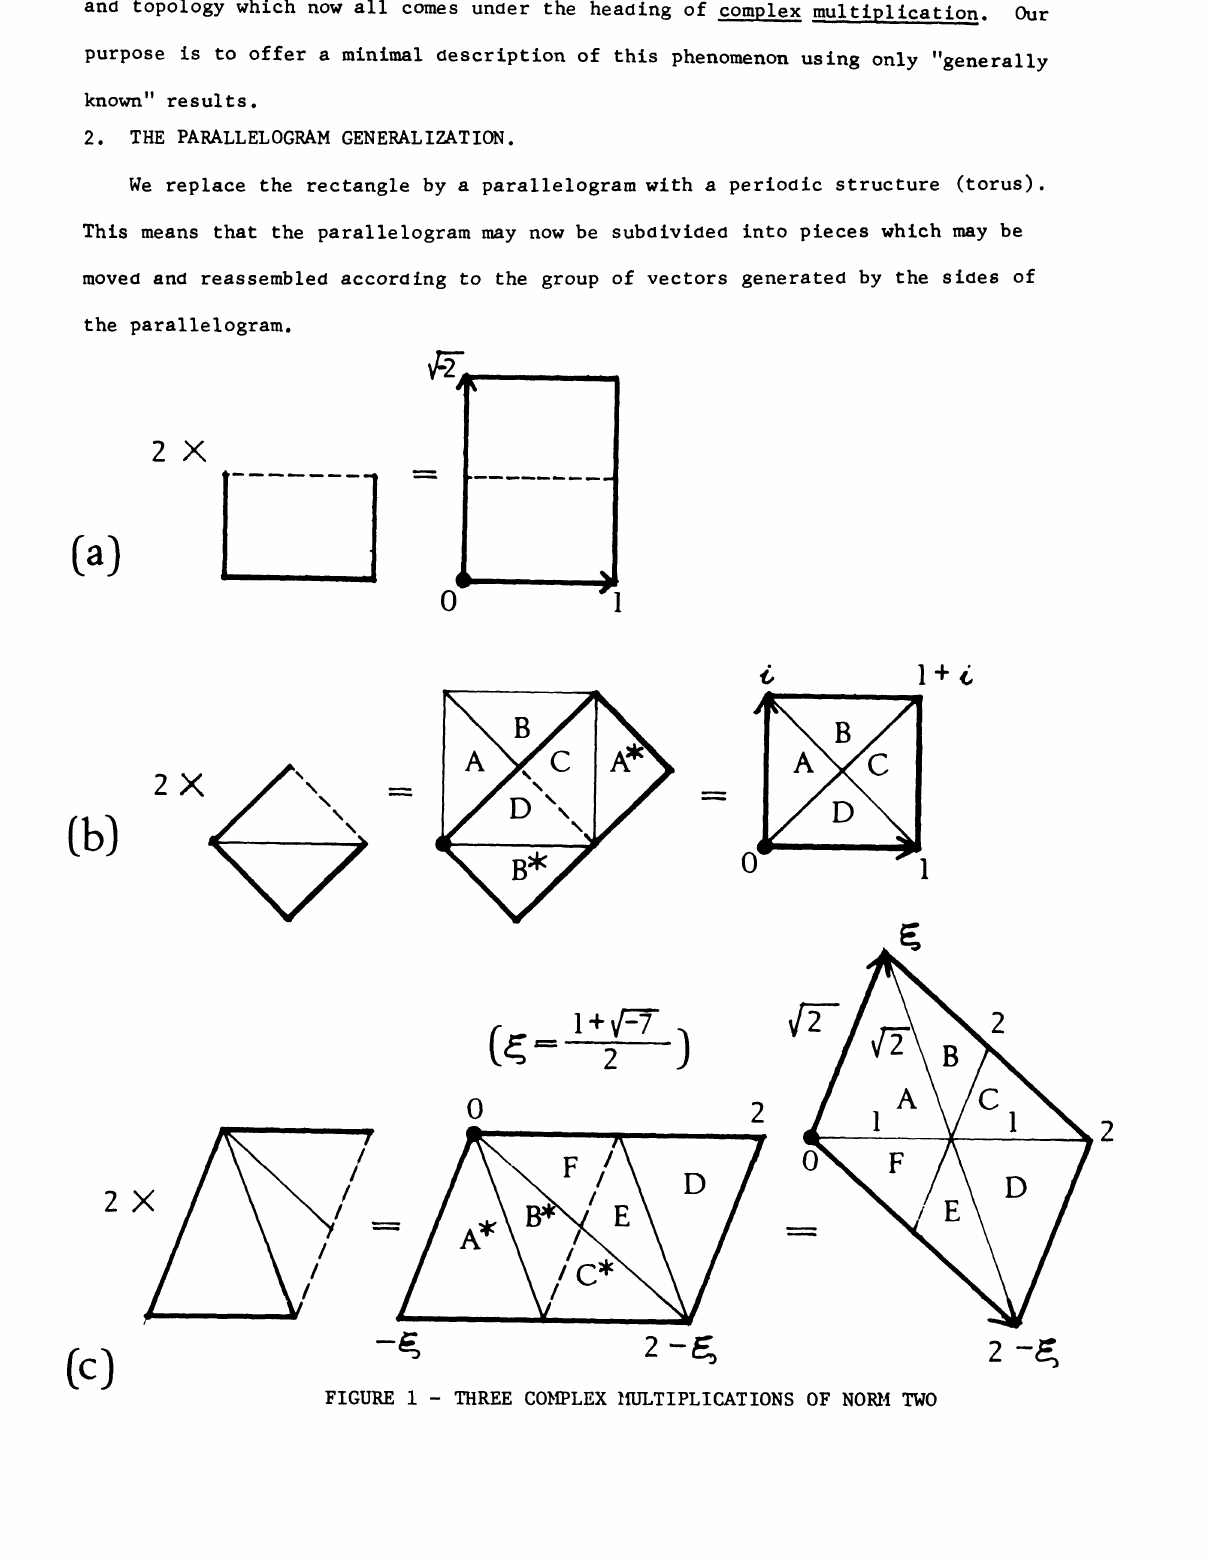
FIGURE i THREE COKPLEX IK[LTIPLICATIONS OF NOP